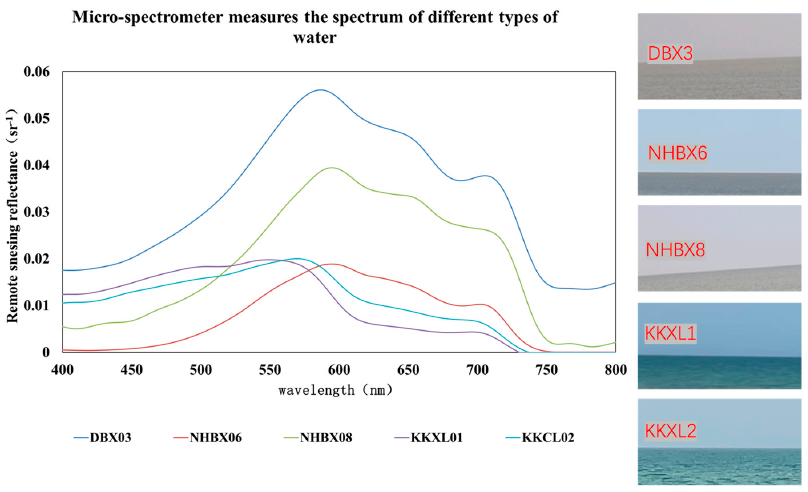
Figure 7. Micro-spectrometer measurements of unmanned areas of Qarhan and Hoh Xil Salt Lake R rs and in situ photos.